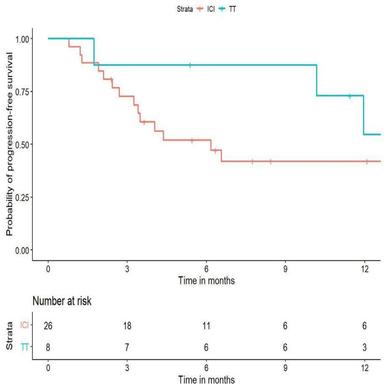
PFS of first-line ICI and TT. Progression free survival (PFS) in months comprises the time from the initiation of systemic treatment to first disease progression, death, or last consultation, whichever occurs first. Estimated median PFS in months 1st systemic treatment: ICI: median PFS 6.2 months, 95% CI 2.6e9.7; 6-months PFS rate: 51.9%; 12-months PFS rate: 42.0%. TT: median PFS 12.6 months, 95% CI 10.0e15.3; 6-months PFS rate: 87.5%, 12-months PFS rate: 54.7%.